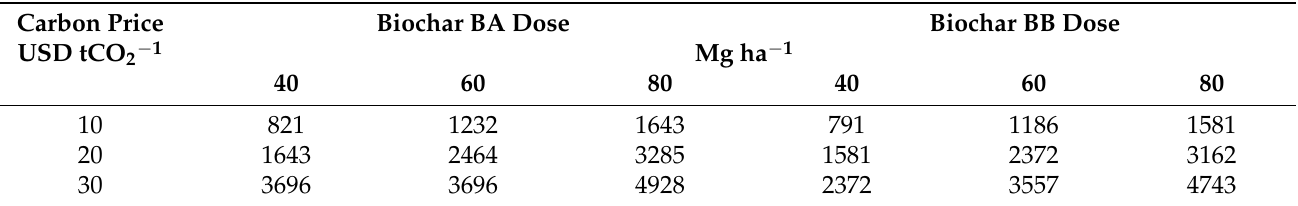
Table 5. Cost–benefit scenarios of carbon sequestration for both biochars, BA and BB, at doses of 40 Mg/ha, 60 Mg/ha and 80 Mg/ha considering the following CO 2 prices: USD 10, 20 and